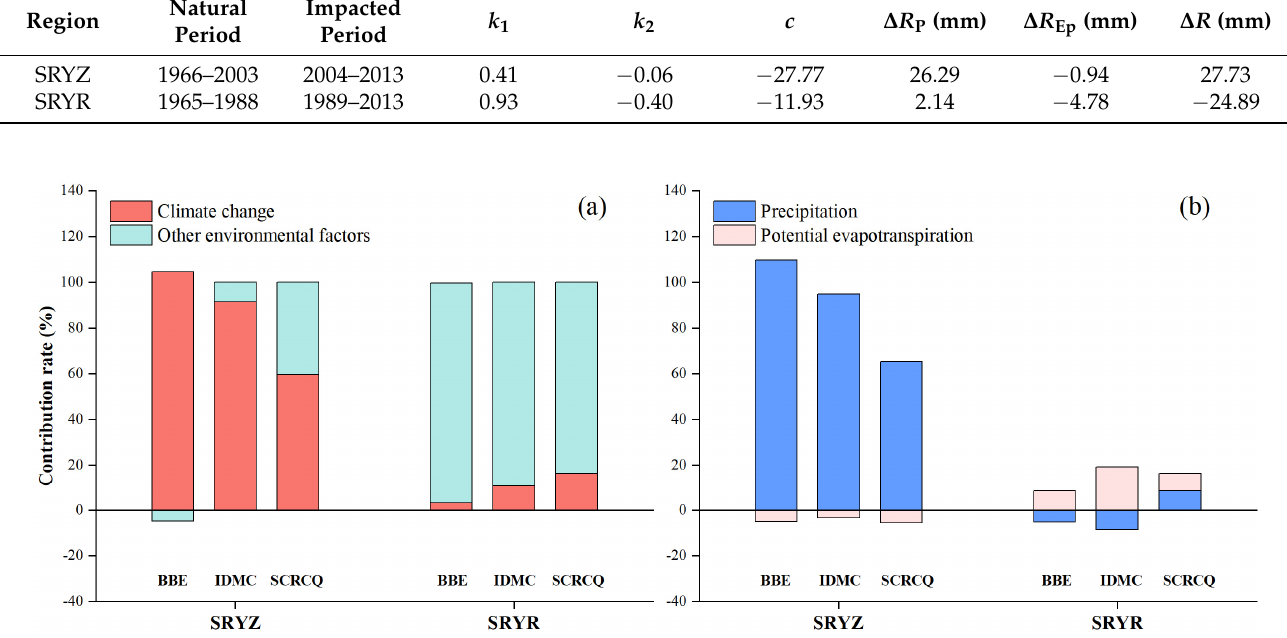
Figure 7. Contributions of climate change (precipitation and potential evapotranspiration ( b )) and other environmental factors ( a ) to runoff variation in the SRYZ and SRYR (BBE, Budyko-based elasticity; IDMC, improved double mass curve; SCRCQ, slope-change ratio of cumulative